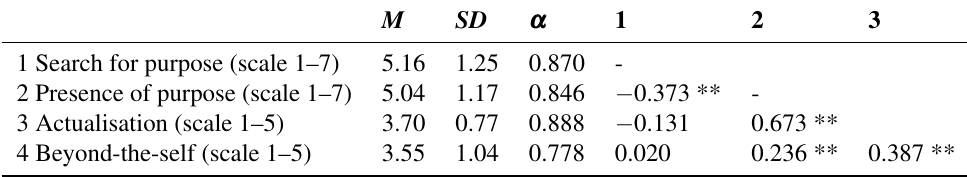
Table 3. Descriptive statistics and Pearson’s r correlations for components of purpose.